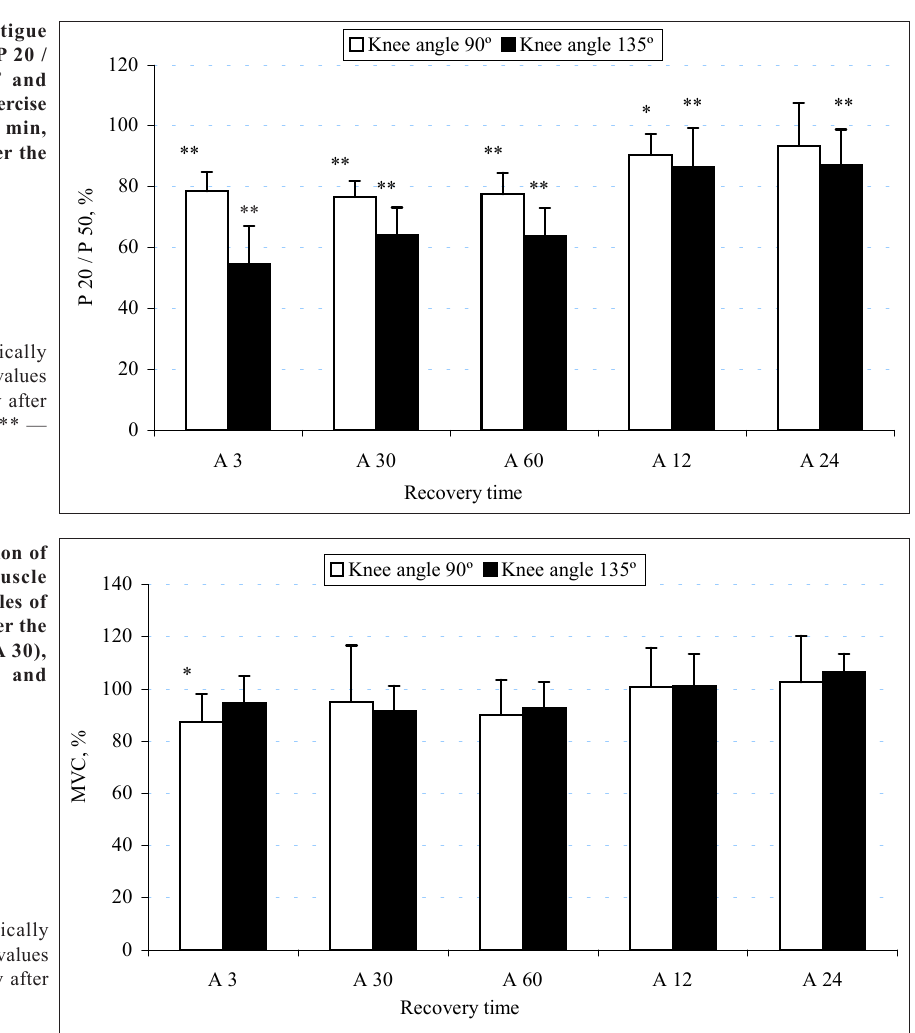
of the same index immediately after the exercise (p <